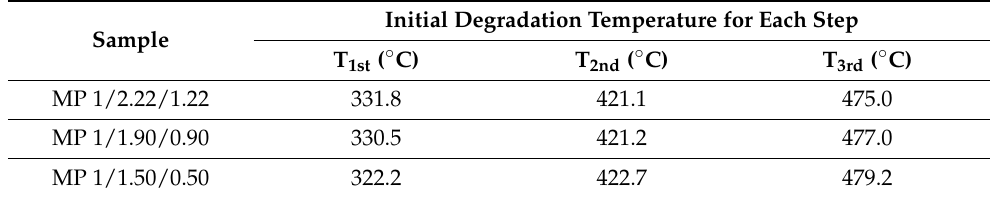
Table 8. Thermal decomposition characteristics of the obtained bio-based SMTPUs.